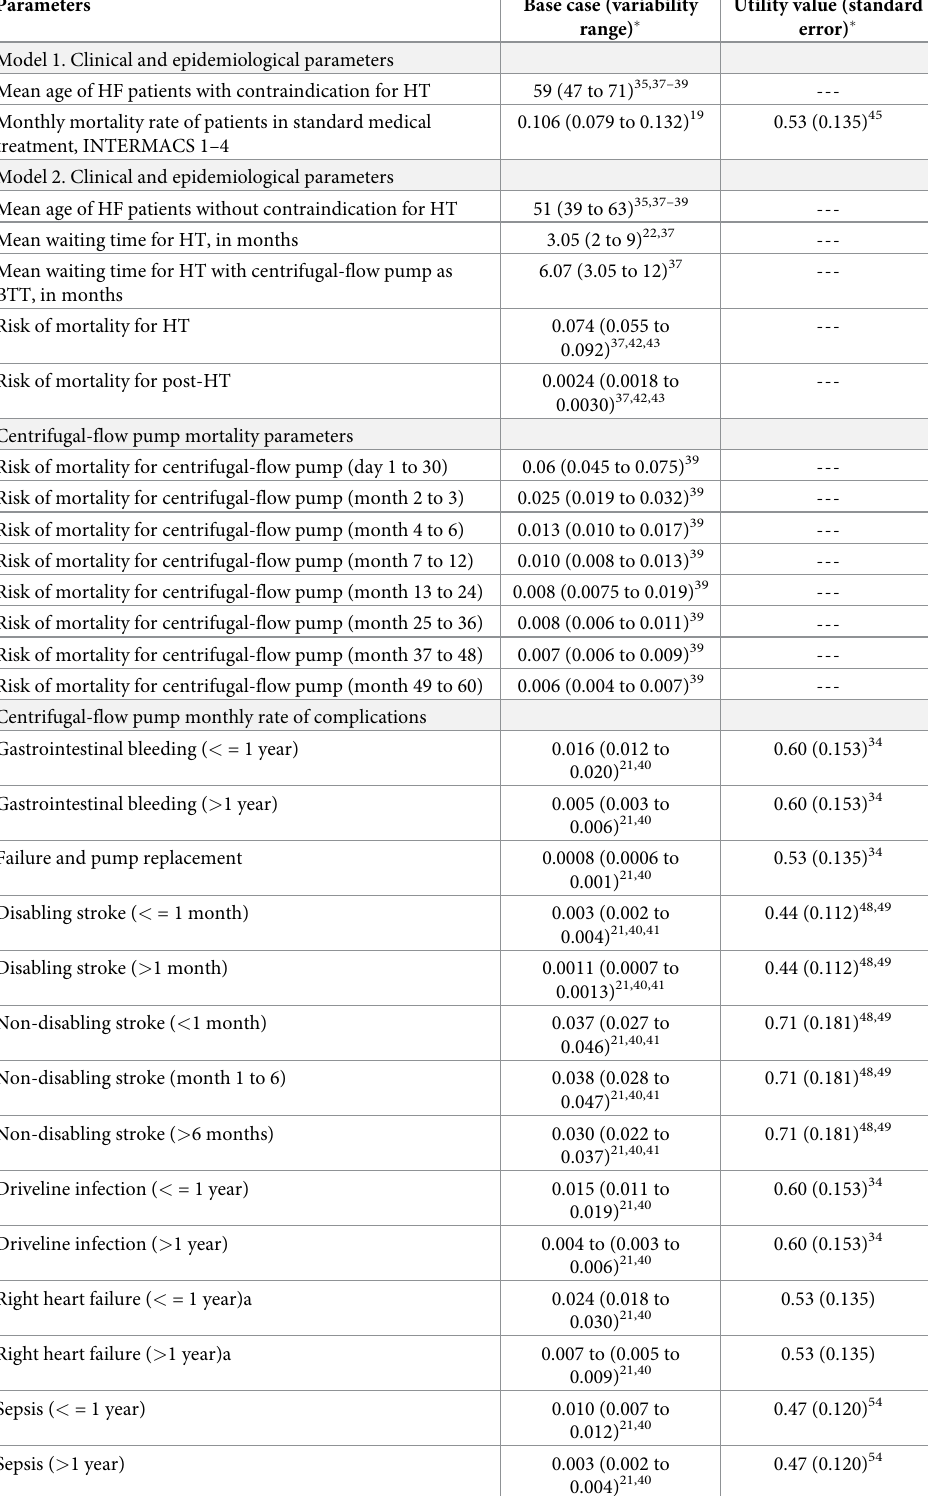
Table 1. Input clinical, epidemiological and utility parameters for both